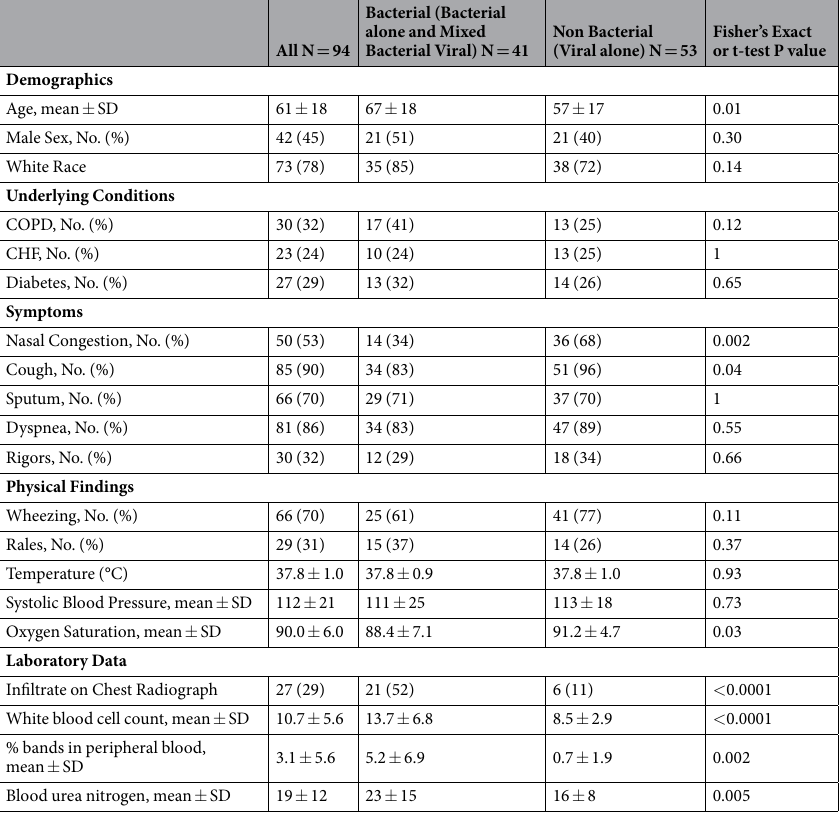
Fig. 4. Pathway and gene names, pathway odds ratios (OR) based upon LASSO and constrained gene OR are presented in Fig. 5A. Sensitivity-specificity analysis indicated models using these gene sets provided a naive area under the receiver-operator curve (AUC) of 0.94, and a conservative, fully nested, cross-validated (NCV) AUC of 0.86.